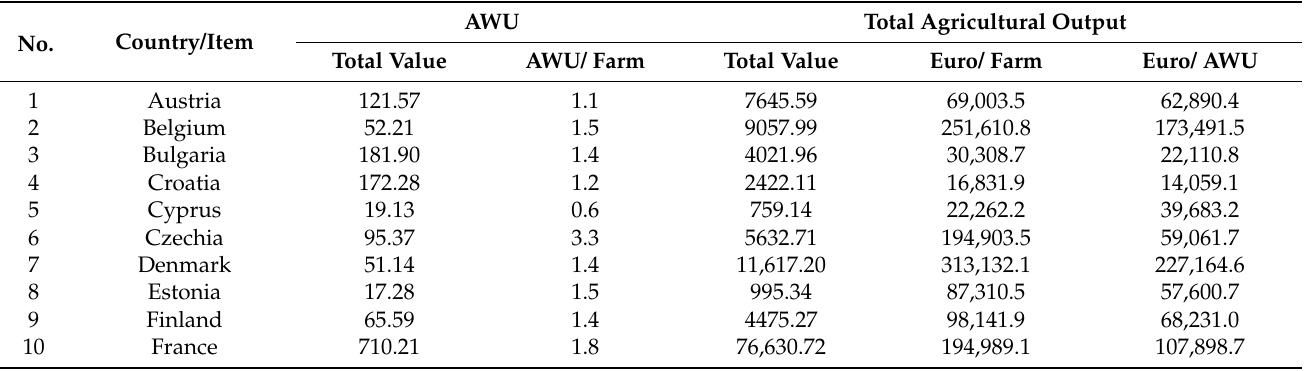
Table 7. EU 2020 Agricultural labor input statistics: AWU (thousand), agricultural output (million